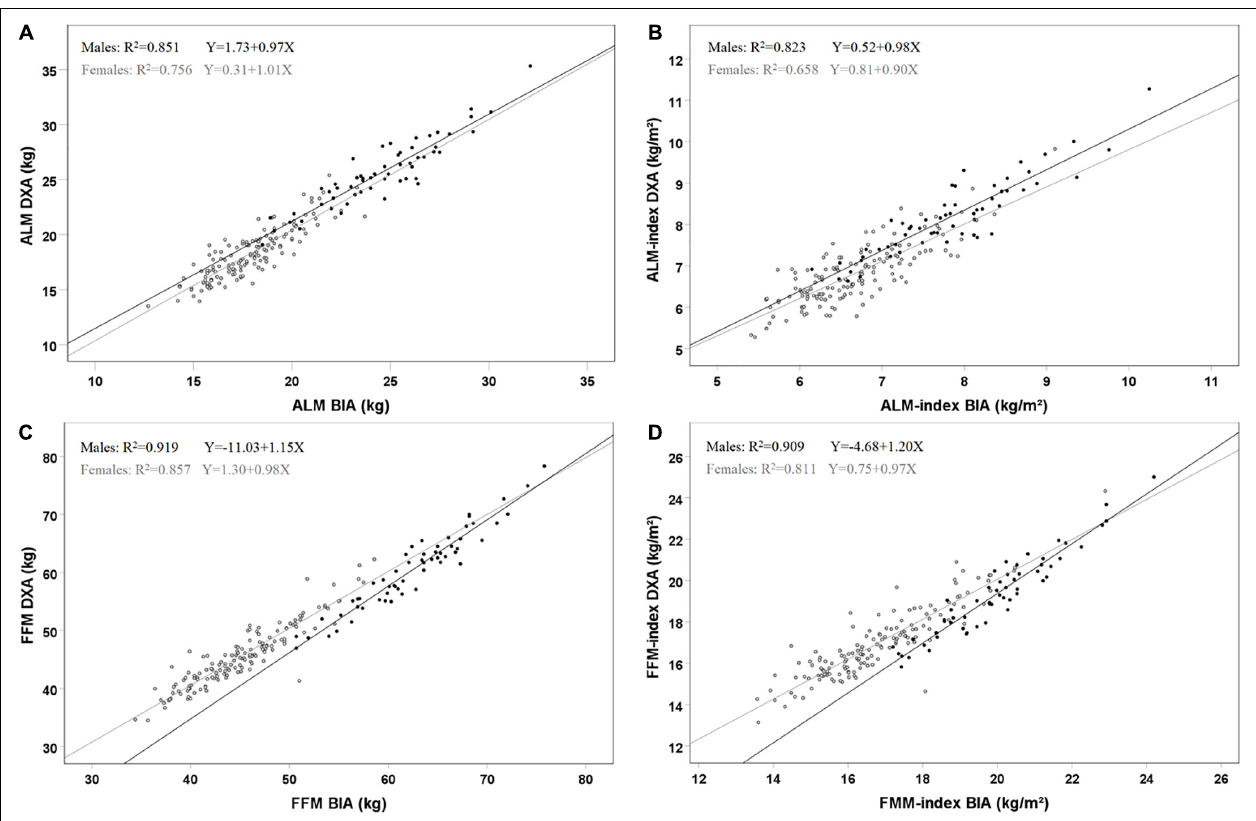
FIGURE 2 | Scatterplots of agreement for BIA and DXA for ALM (A) , ALM-index (B) , FFM (C) and FFM-index (D) in 202 subjects (58 males, 144 females). Black dots and lines represent males, and gray dots and lines females. R 2 and regression lines are reported in the plots. (A) males [F(1, 56) = 320.2, p < 0.001] and females [F(1, 142) = 439.2, p < 0.001]; (B) males [F(1, 56) = 260.2, p < 0.001] and females [F(1, 142) = 272.8, p < 0.001]; (C) males [F(1, 56) = 637.0, p < 0.001] and females [F(1, 142) = 849.3, p < 0.001]; (D) males [F(1, 56) = 556.1, p < 0.001] and females [F(1, 142) = 611.3, p <